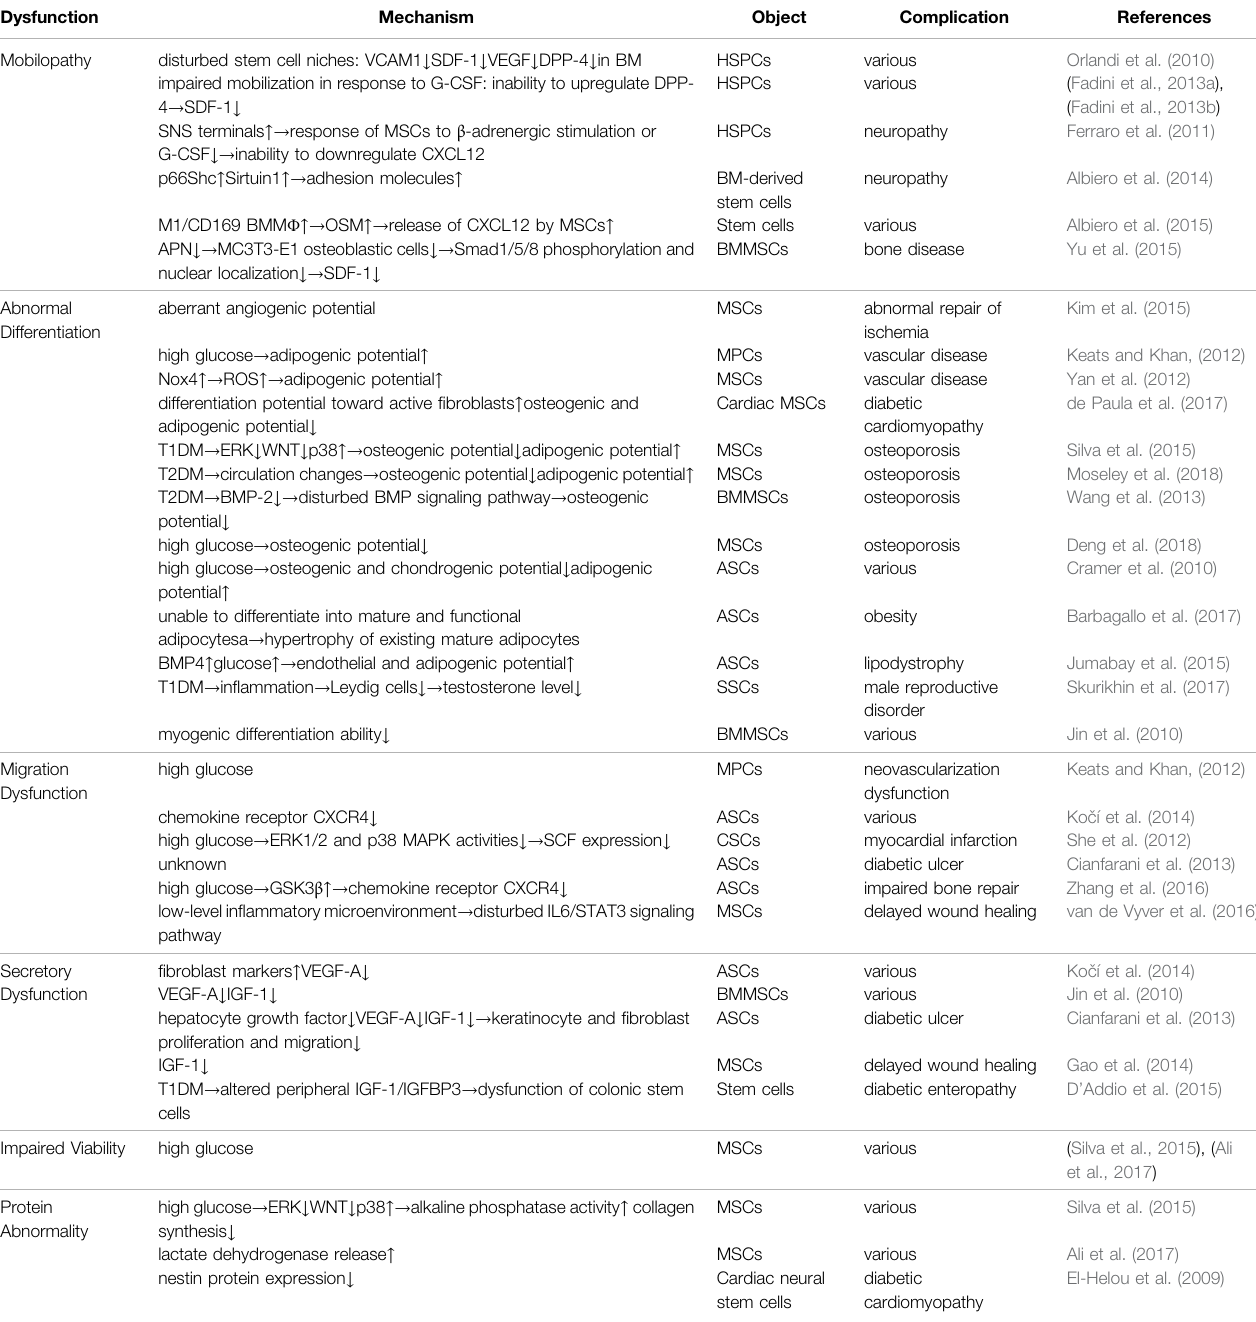
TABLE 1 | Summarizes the mechanisms, objects, complications and the corresponding references of stem cells dysfunctions in